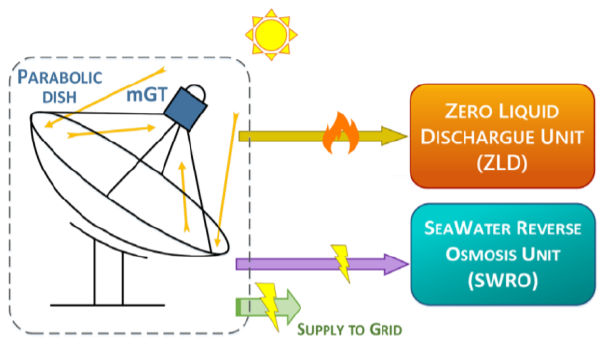
Figure 1. The SOLMIDEFF